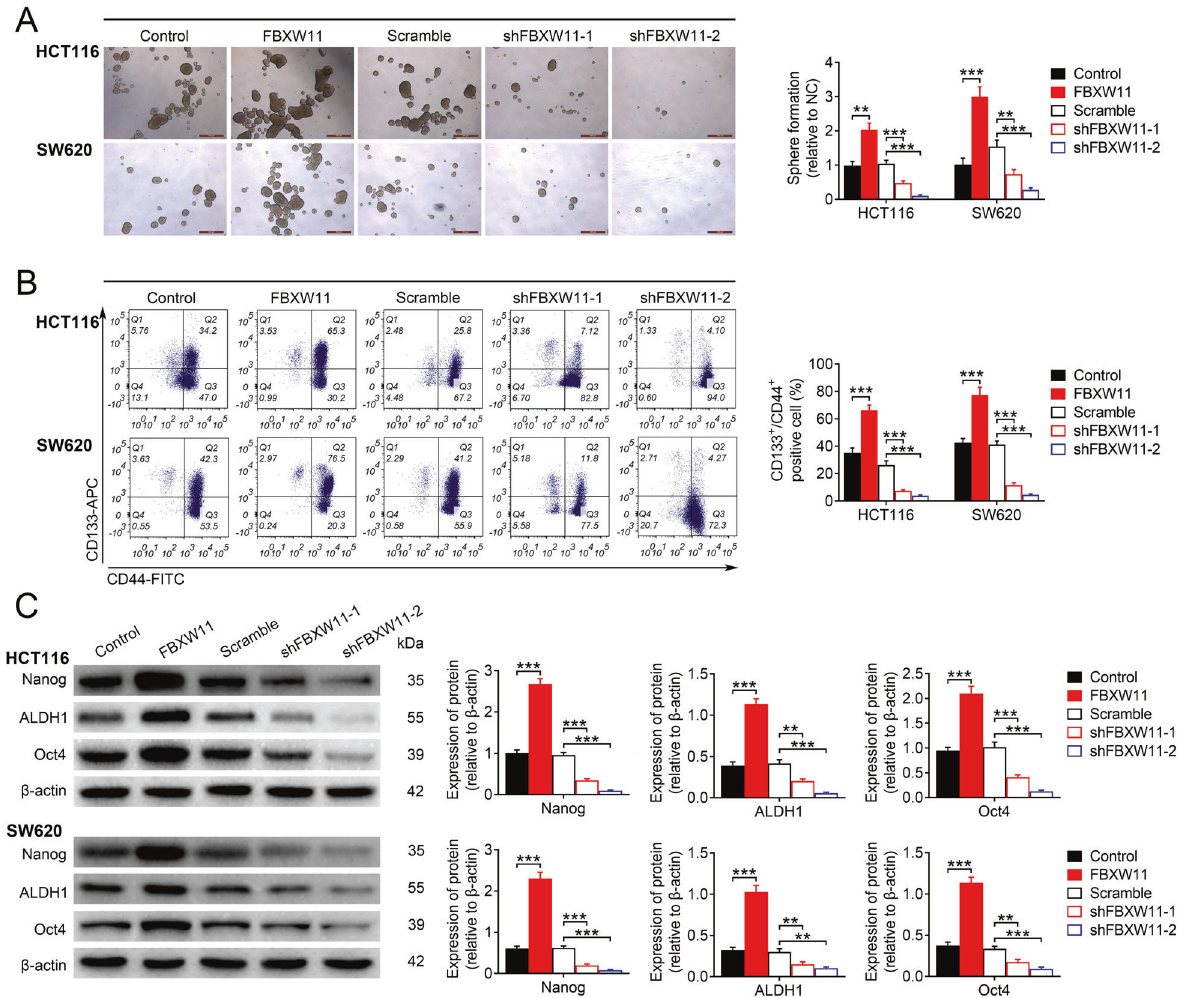
Fig. 3 Effect of FBXW11 on maintaining stem-cell-like properties in CRC cells. HCT116 and SW620 cells were transfected with recombinant lentiviral vectors carrying FBXW11, shRNAs targeting FBXW11, or corresponding controls. A The sphere-forming ability of CRC cells following transfection was evaluated by cultivating one single cell in growth medium for 7 days. The number of spheres (diameter >50 μ m) were counted and normalized to the group transfected with empty control lentiviral vector. B Transfected CRC cells were stained with anti-CD44- FITC and anti-CD133-APC antibodies, and then sorted by fl ow cytometry. The percentage of CD133 + /CD44 + cells in each group was calculated. C The protein expressions of Nanog, ALDH1, and Oct4 were measured by western blotting. ANOVA followed by Bonferroni ’ s post hoc test was used for statistical comparisons among multiple